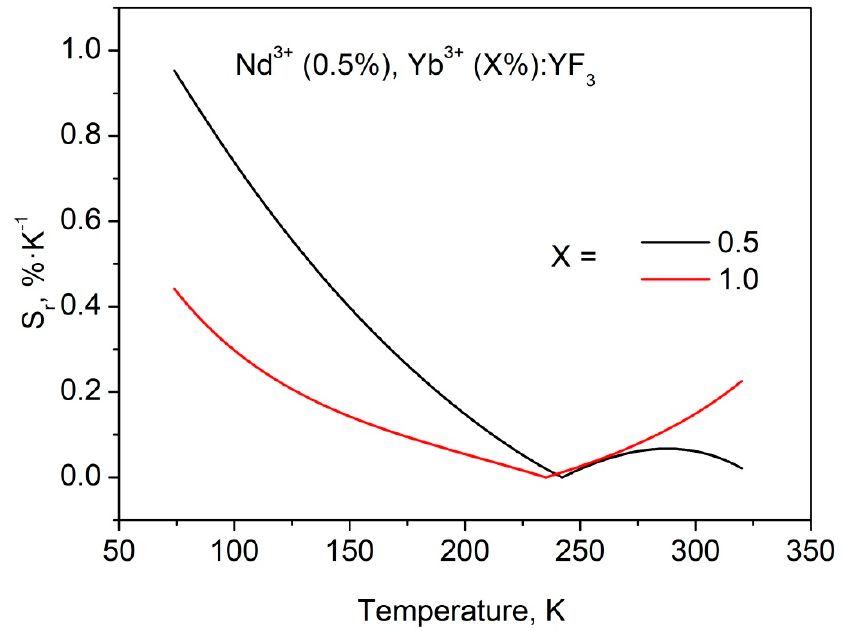
Figure 8. S r a functions of temperature obtained from LIR curves for Nd 3+ (0.1 mol.%), Yb 3+ (X mol.%):YF 3 sample.